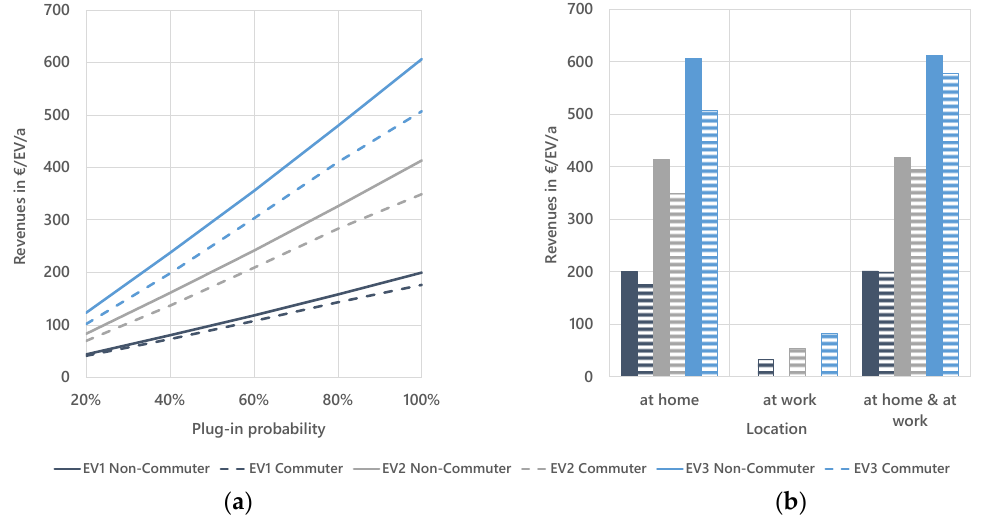
Figure 8. ( a ) Influence of plug-in probability on revenue potentials of bidirectionally chargeable EVs using arbitrage trading; ( b) influence of charging point location on revenue potentials of bidirectionally chargeable EVs using arbitrage trading.